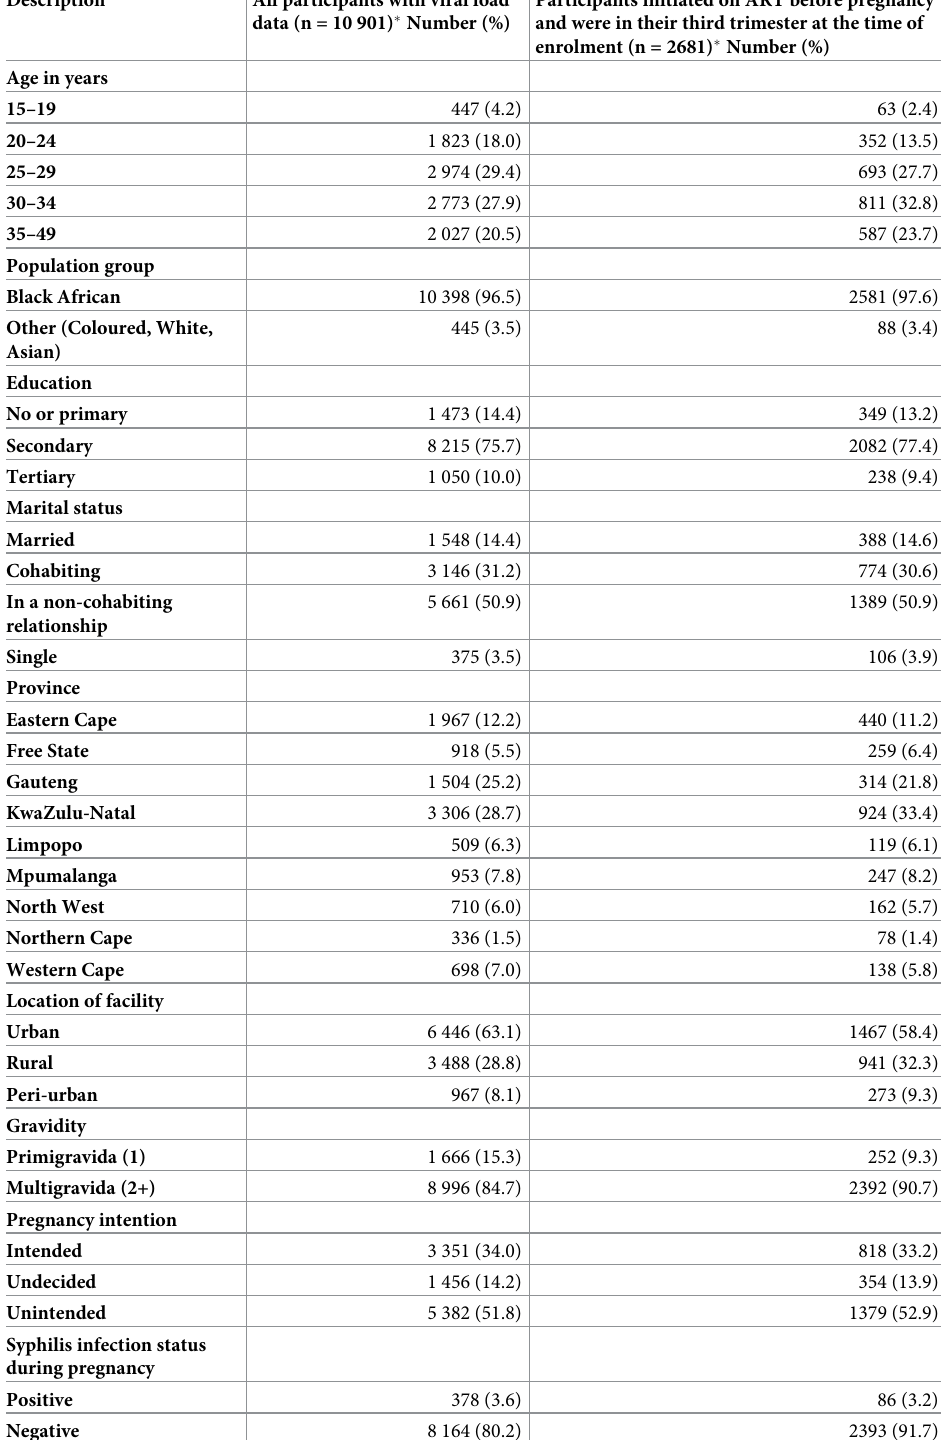
Table 1. Demographic and clinical characteristics of participants, antenatal HIV Sentinel Survey, 2019, South